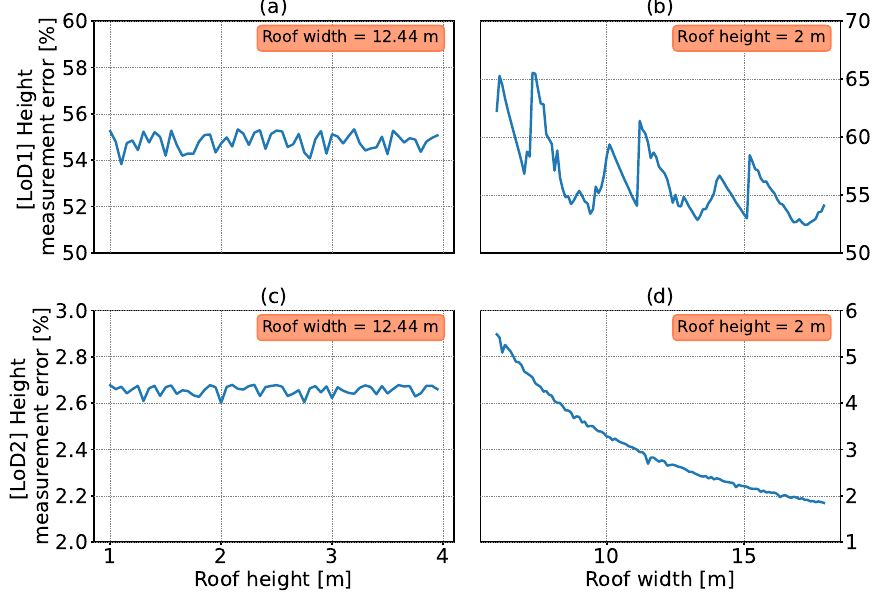
Figure 3. Worst-case scenario measurement error (WCSME) for LoD1 and LoD2 measurements as a function of roof height and roof